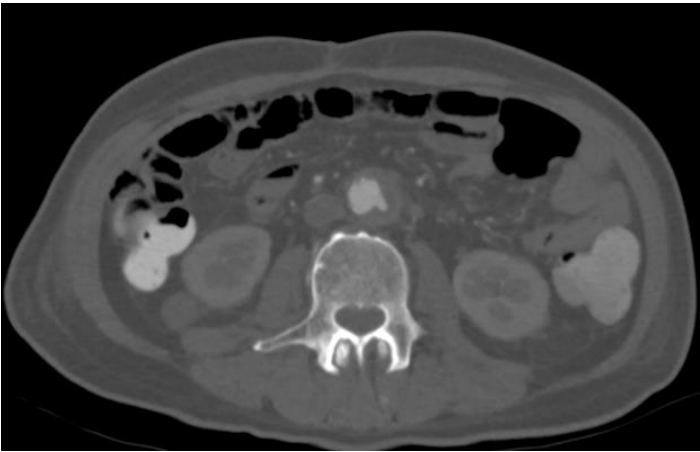
Figure 1. Interim development of an infra-renal mycotic aneurysm measuring 2.5 cm.